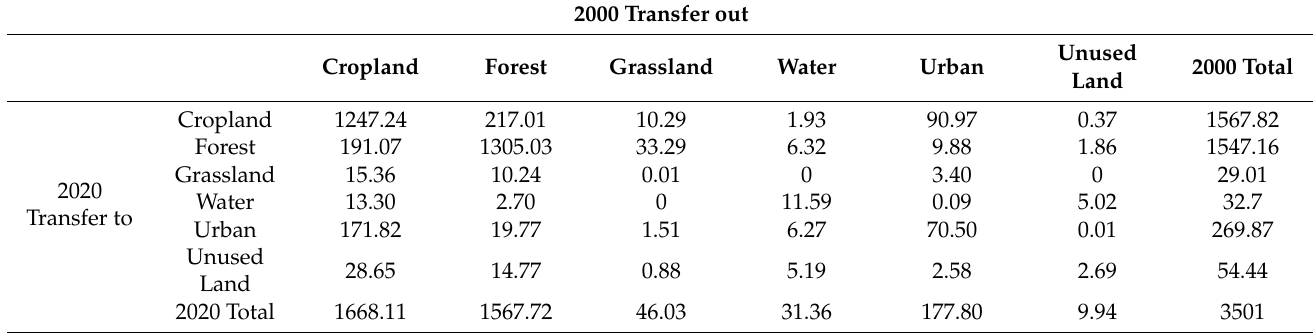
Table 9. Land Use Transfer Matrix 2000~2020 (km 2